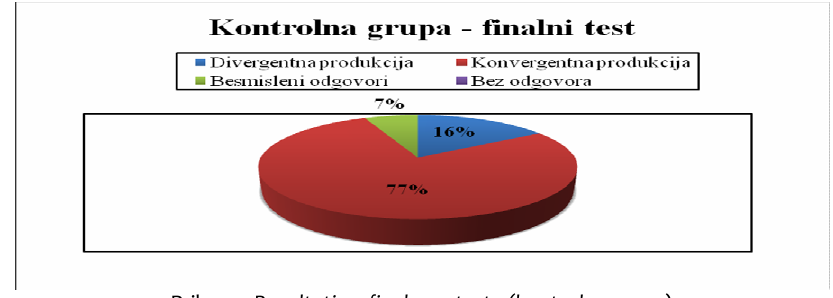
Veliki broj učenika kontrolne grupe ponavljao je iste odgovore. Nije bilo učenika koji